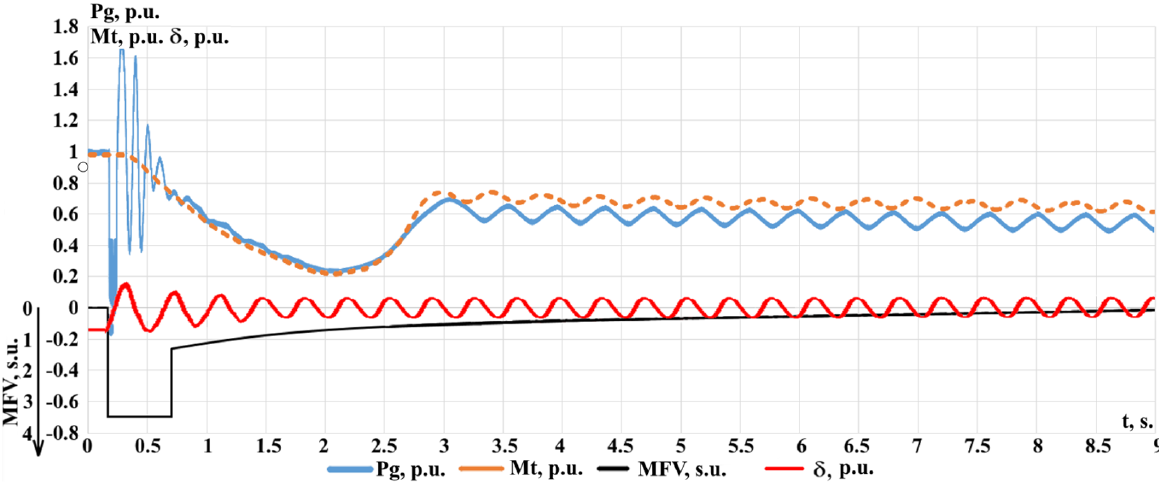
Figure 21. Generator G 2 active power, turbine torque, and angle for the Case 3.